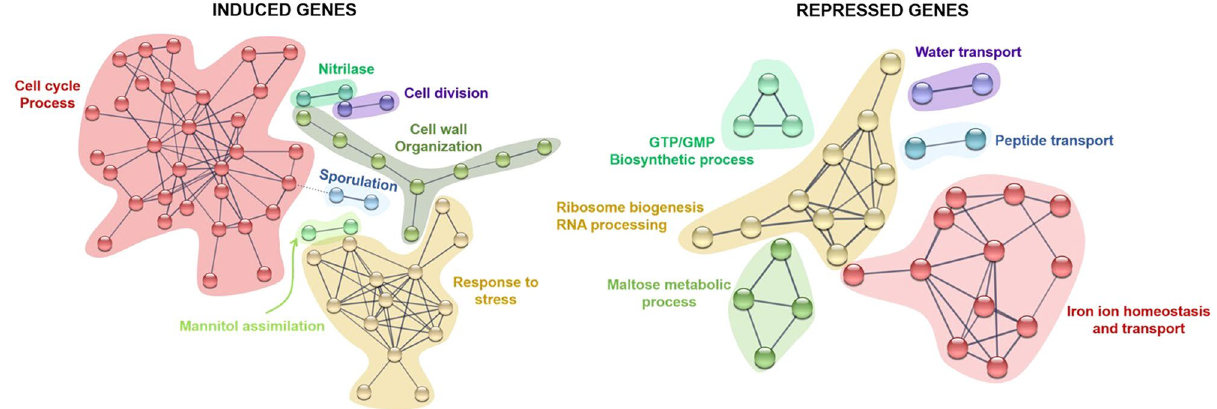
Figure 5. STRING analysis showing protein–protein interactions between induced and repressed genes. STRING software v11 [https:// string- db.